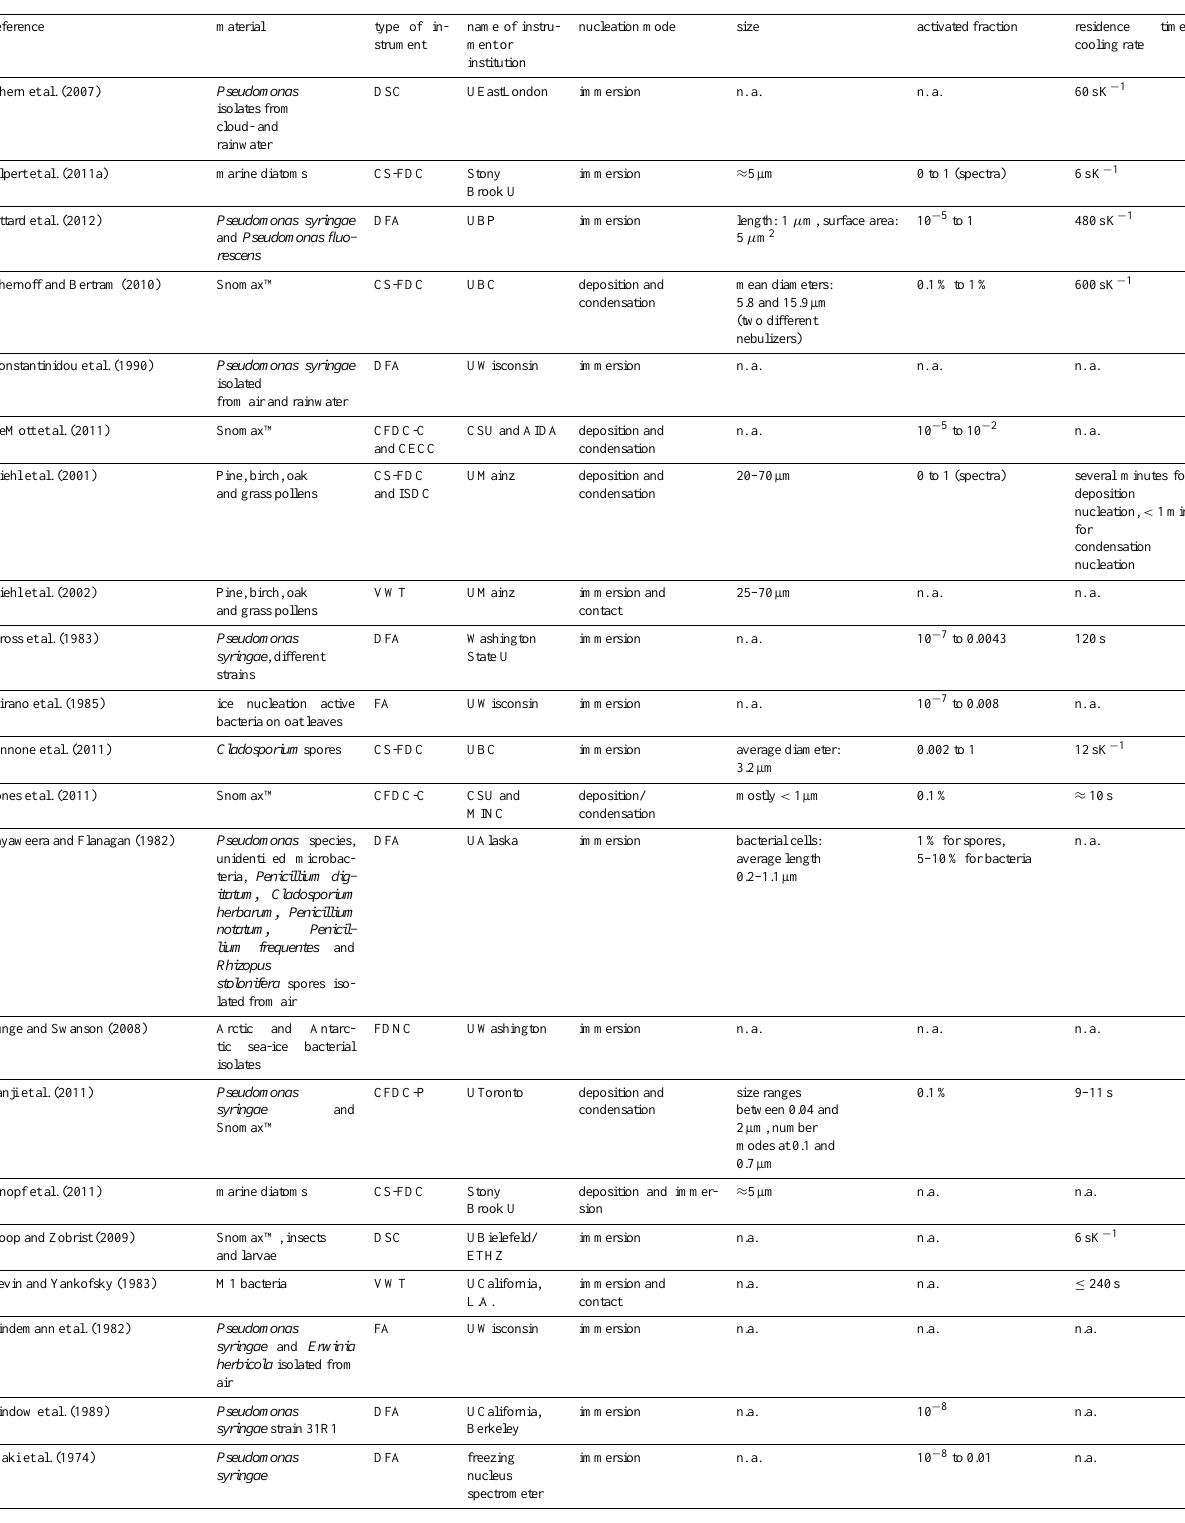
Table 3. Laboratory experiments with